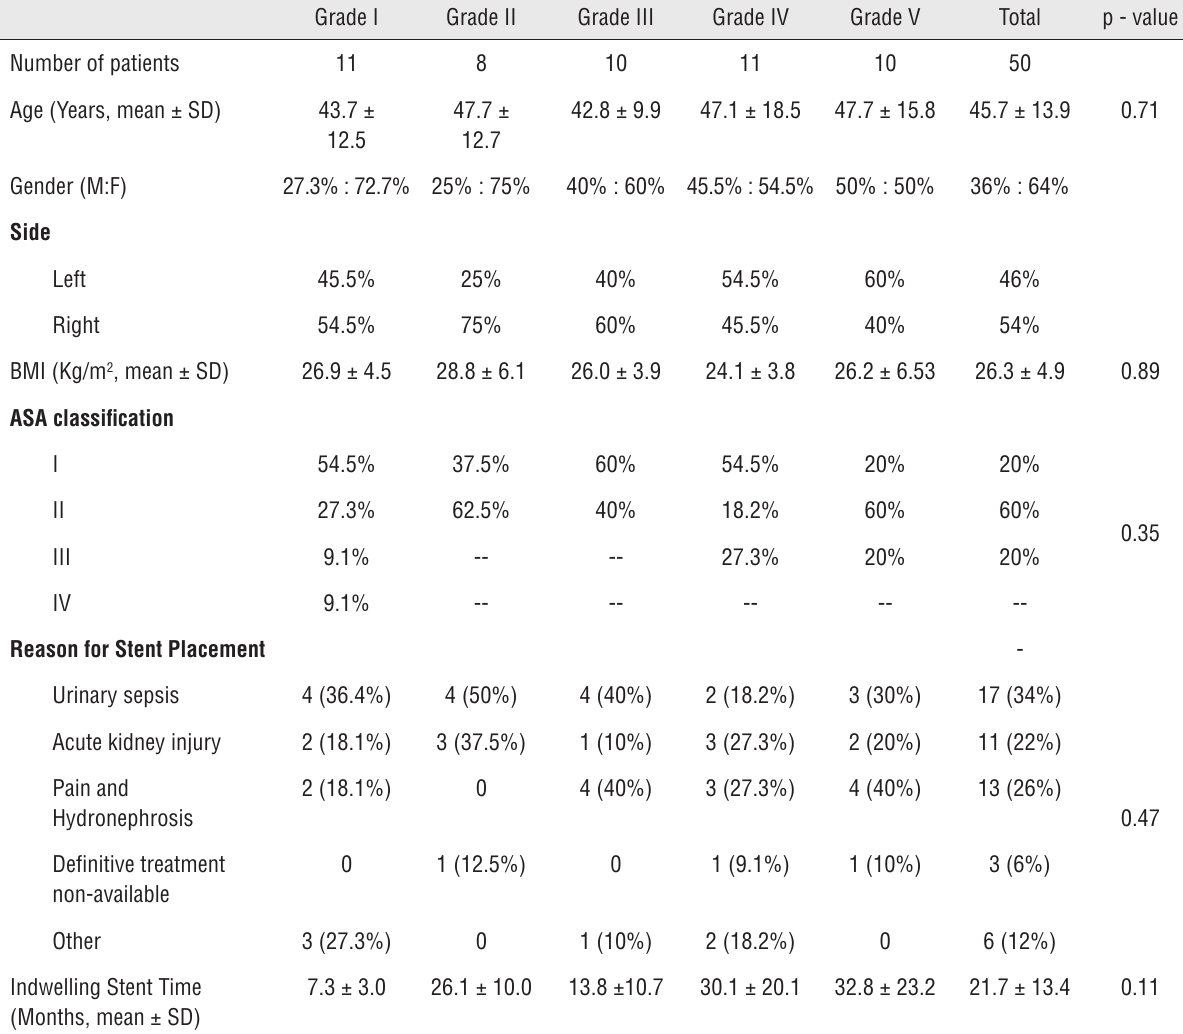
Table 1 - Demographic data of patients presenting encrusted ureteral stents according to the FECal